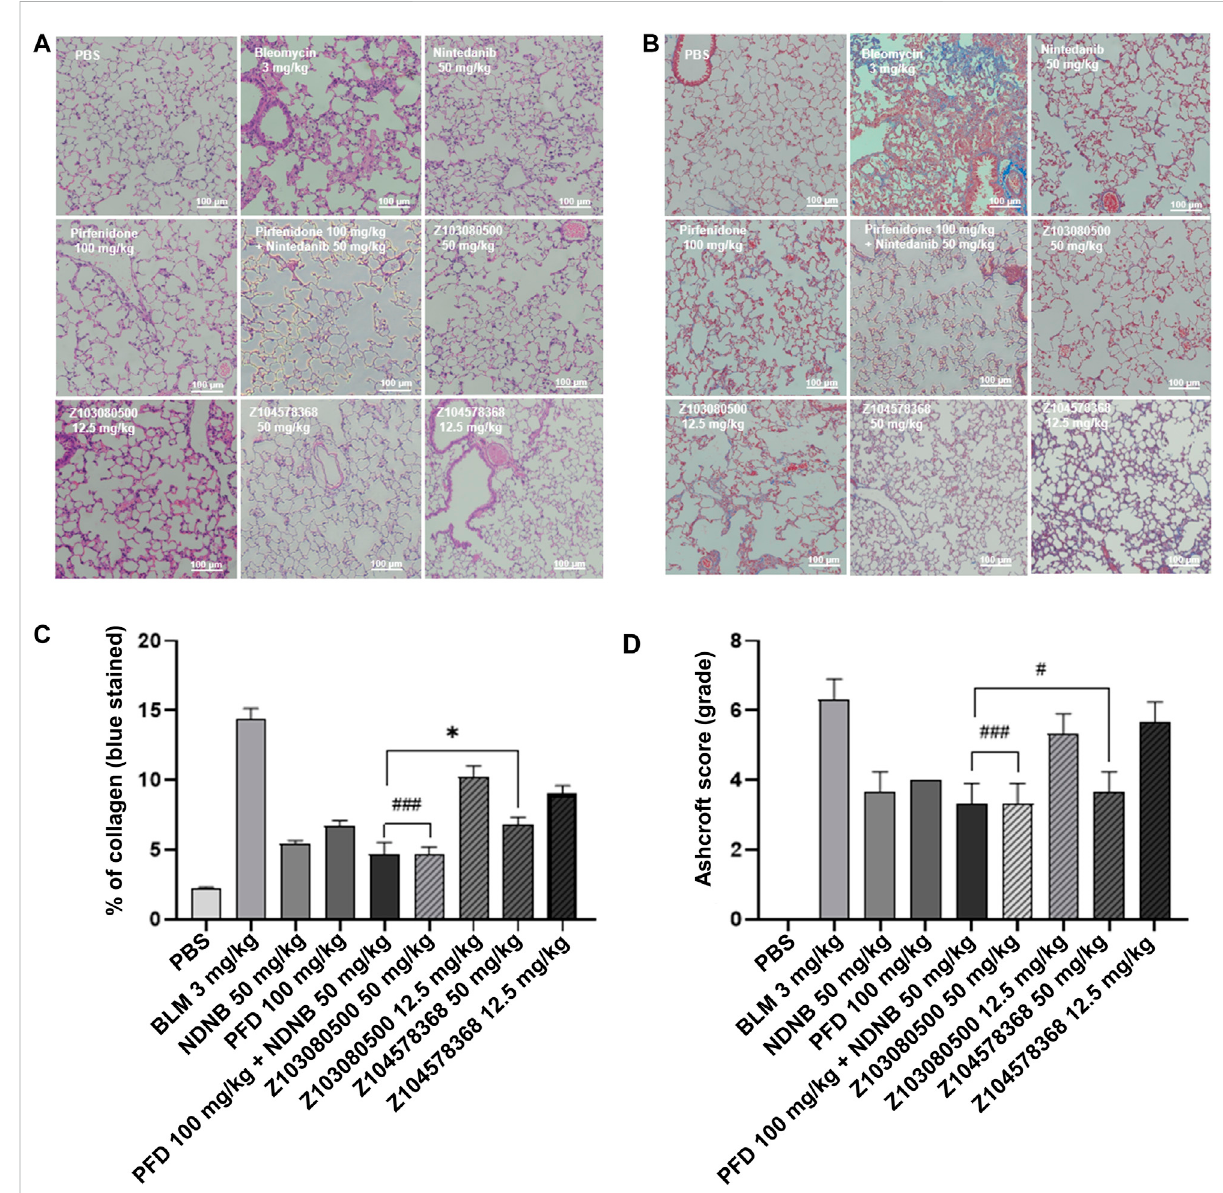
FIGURE 5 HE-stained sections and Masson trichrome-stained sections. (A) HE-stained section. (B) Masson trichrome-stained section. Grouping is marked in the diagram. (C) Quantitative analysis of Masson-stained sections. (D) Ashcroft score. Doses and groups have been marked on the abscissa. All experiments were performed in triplicate independently. BLM: BLM. NDNB: NDNB. PFD: